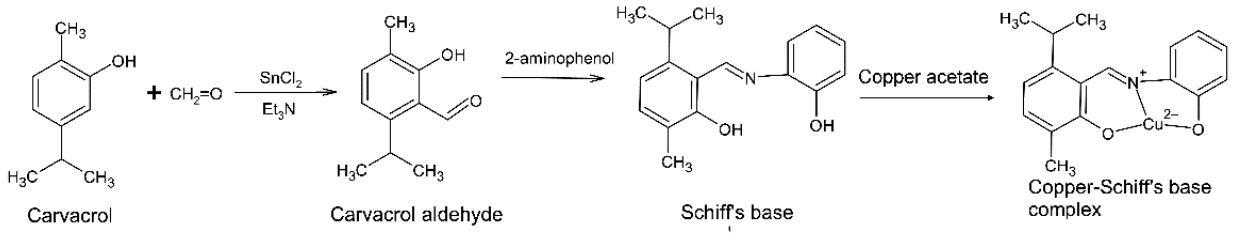
Figure 2. Reaction showing the synthesis of the copper–Schiff base complex from carvacrol.